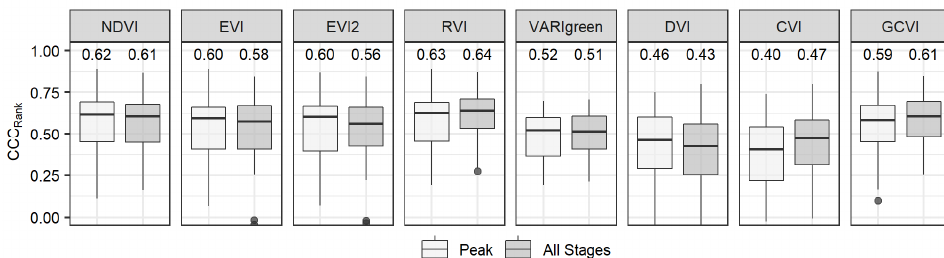
Figure 4. The concordance correlation coefficients of ranks for multi-stages single-index analysis. Values show the median CCC Rank for each treatment. For better visualisation, the figure excluded negative CCC Rank.